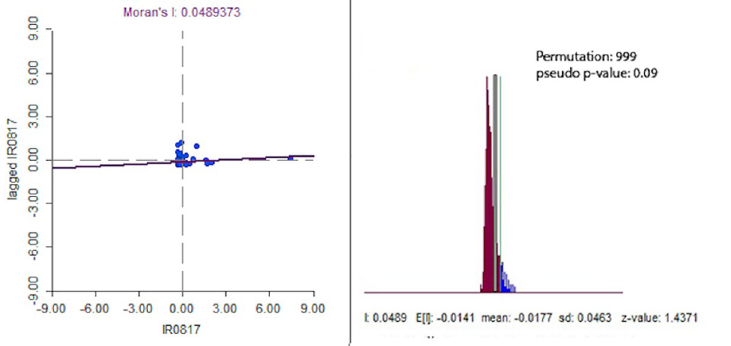
Fig 5. Moran’s I statistic and associated p-values based on 999